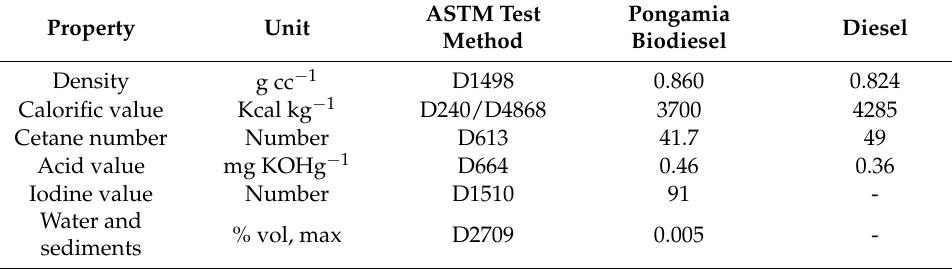
Table 4. Properties of pongamia methyl